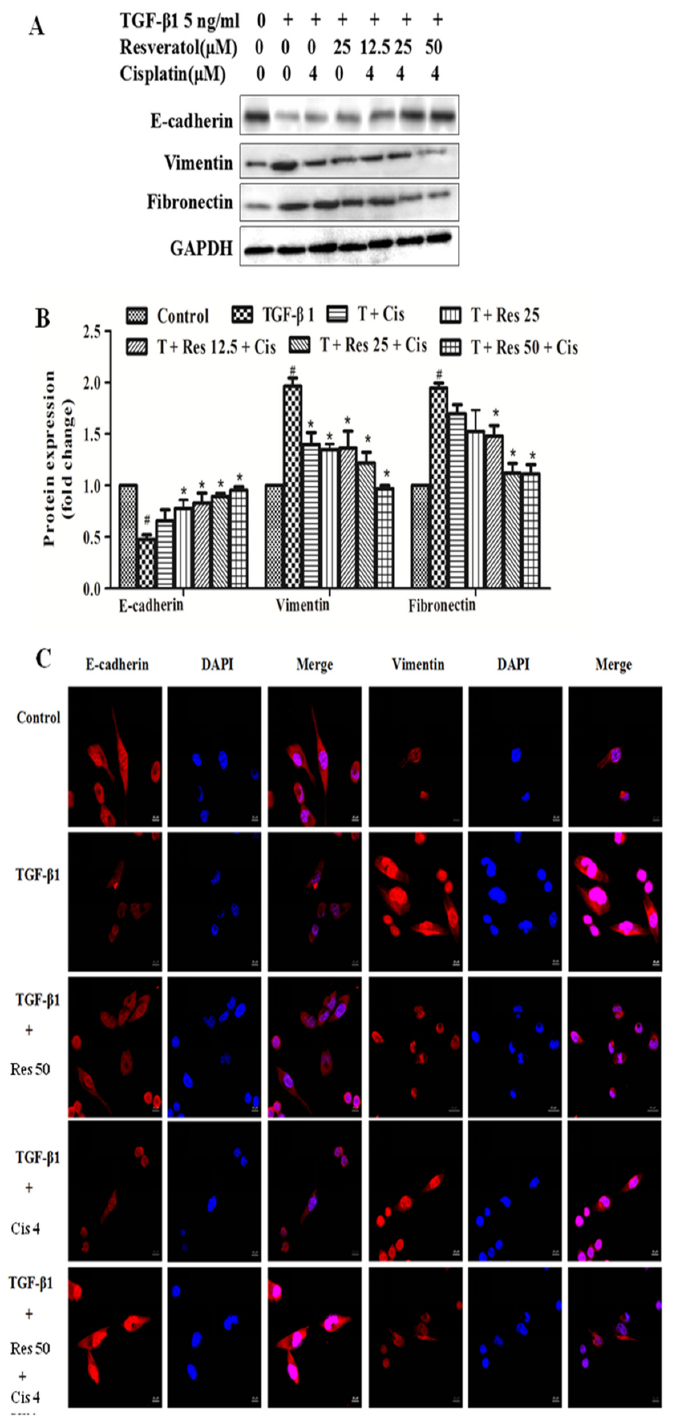
Figure 3. Regulatory effect of resveratrol combined with cisplatin on TGF- β 1-induced epithelial and mesenchymal molecular markers in MDA231 cells. ( A ) TGF- β 1-induced expressions of E-cadherin, vimentin and fibronectin treated by 5 ng/mL TGF- β 1, 12.5 µ M, 25 µ M, 50 µ M resveratrol, 4 µ M cisplatin or resveratrol + cisplatin + TGF- β 1 for 24 h. ( B ) Protein expression fold change. The experiment was repeated three times, # p < 0.01, vs. control group; * p < 0.05, vs. TGF- β 1-treated group. ( C ) TGF- β 1-induced expressions of E-cadherin and vimentin with immunofluorescence assay, treated by 50 µ M resveratrol and 4 µ M cisplatin for 24